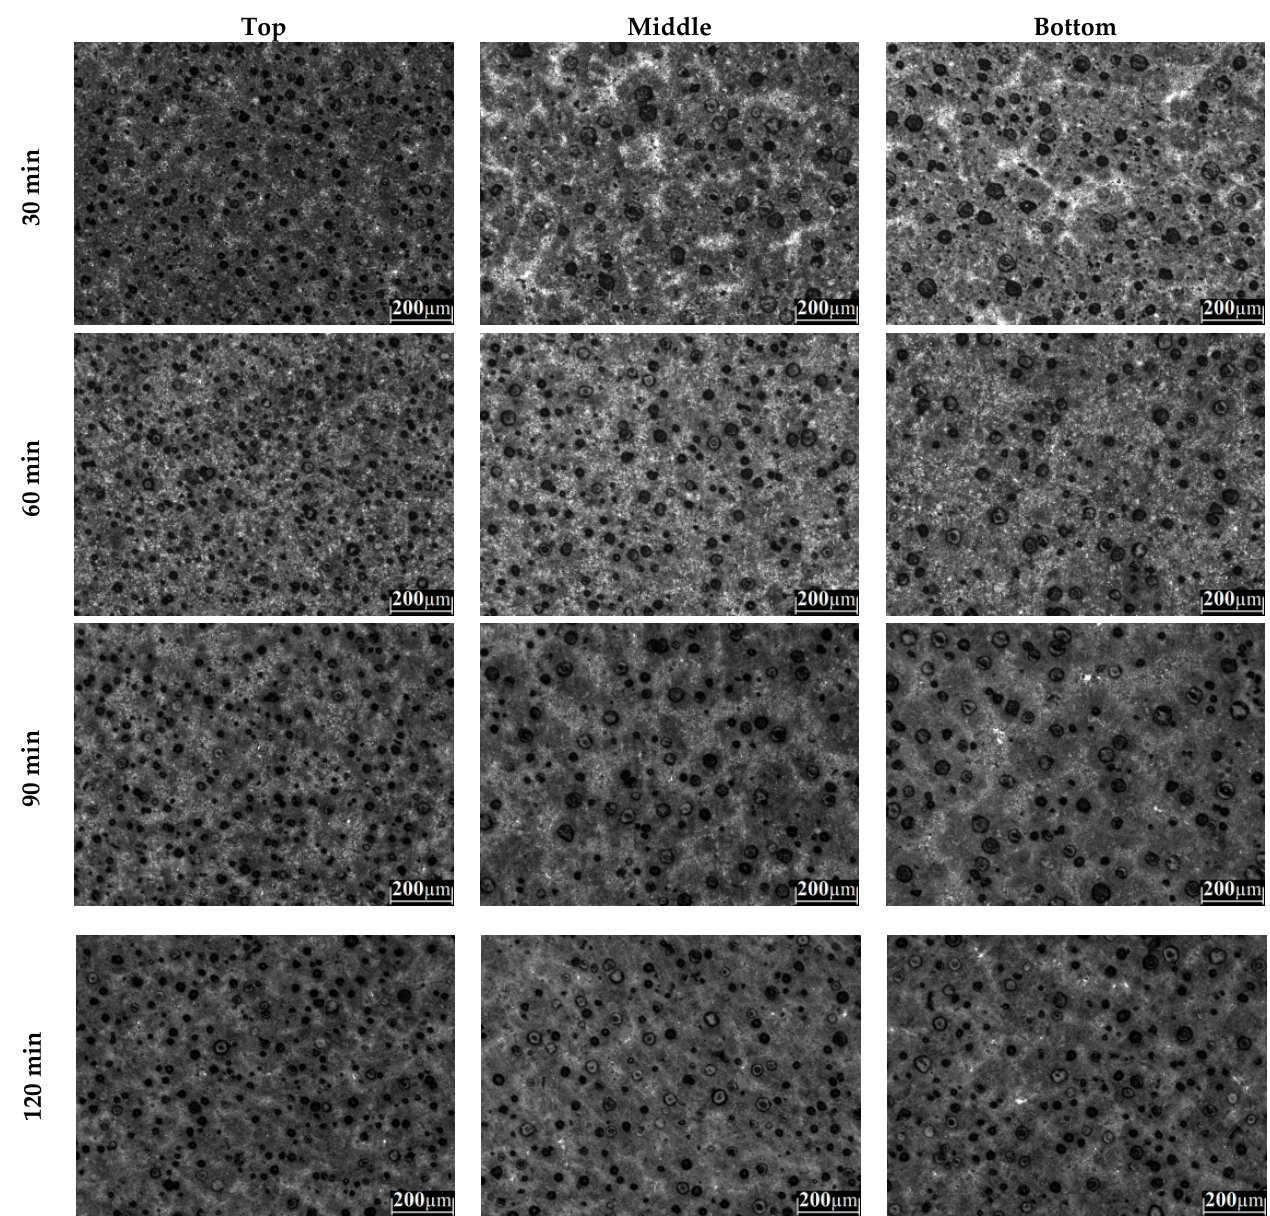
Figure A1. Microstructural evolution for the ADI ‐ 0.3V ‐ 265 sample at the austempering times of 30, 60, 90, and 120 min. Top Middle Bottom